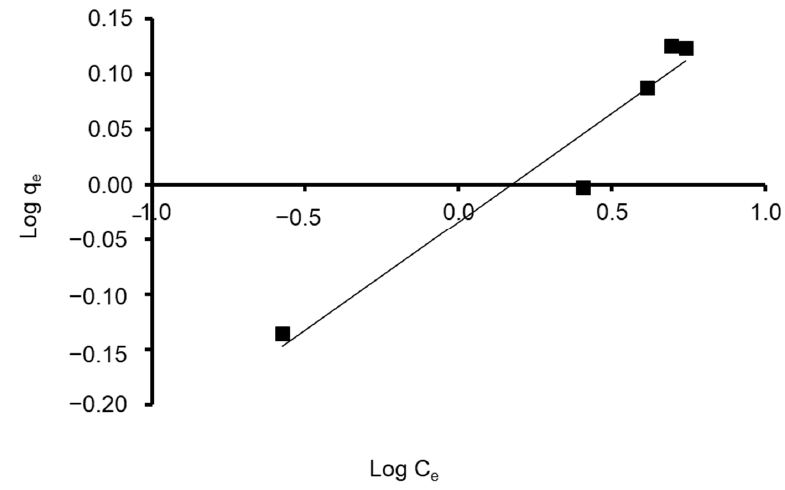
Figure 11. Plot of the Freundlich isotherm model for CVD adsorbed onto S. costatum .